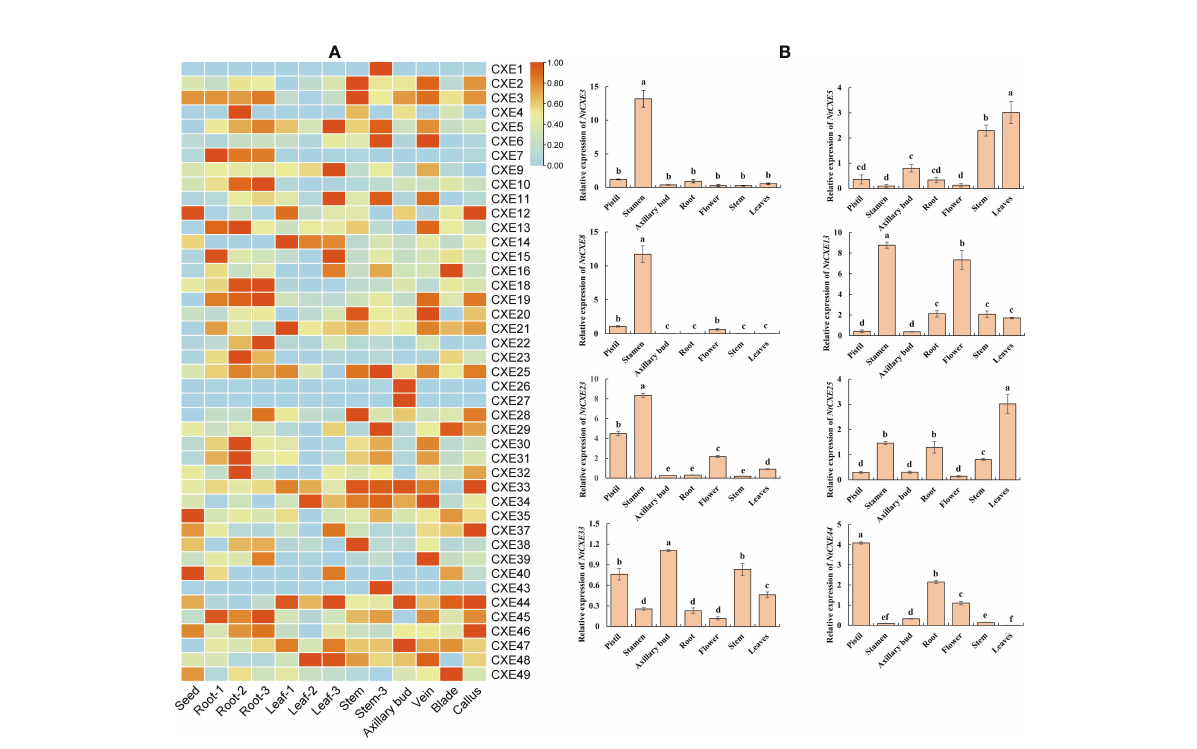
FIGURE 5 Analysis of tobacco NtCXE genes in various plant tissues. (A) Expression speci fi city of all NtCXE genes in various plant tissues, some with three developmental stages. ‘ 1 ’ , ‘ 2 ’ , and ‘ 3 ’ represent the seedling stage, mature stage, and 2 d after topping, respectively. Heat maps were drawn by TBtools using FPKM mean values, scaled by rows. Color represents the gene expression levels (orange, high expression level; and blue, low expression level). (B) qRT-PCR analysis of NtCXE3 , NtCXE5, NtCXE8, NtCXE13, NtCXE23, NtCXE25, NtCXE33, NtCXE44 in axillary buds, fl owers, leaves, roots, terminal buds, and veins. Data are presented as means ± SDs (n = 3). Different letters indicate signi fi cant differences between various tissues, based on one-way